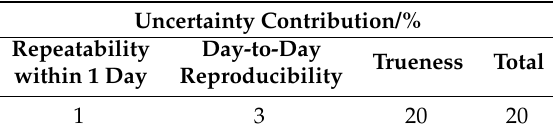
Table A9. Relative uncertainty budget for